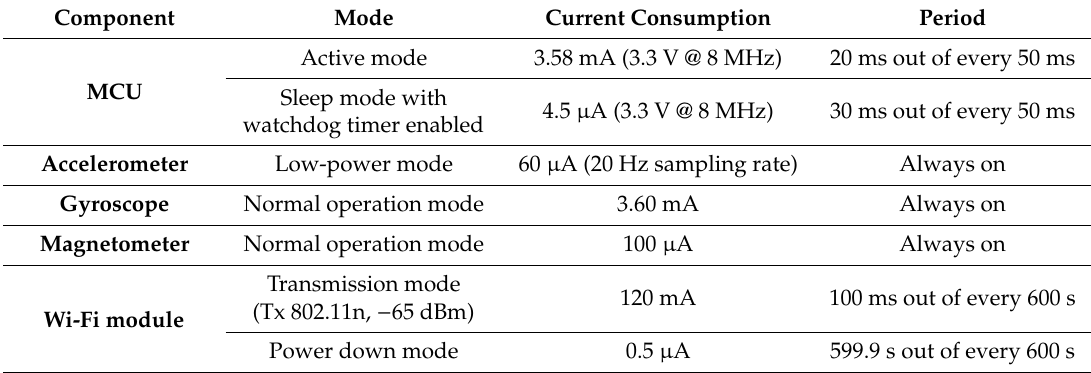
Table 2. Current consumption and operation mode of main components implemented in proposed